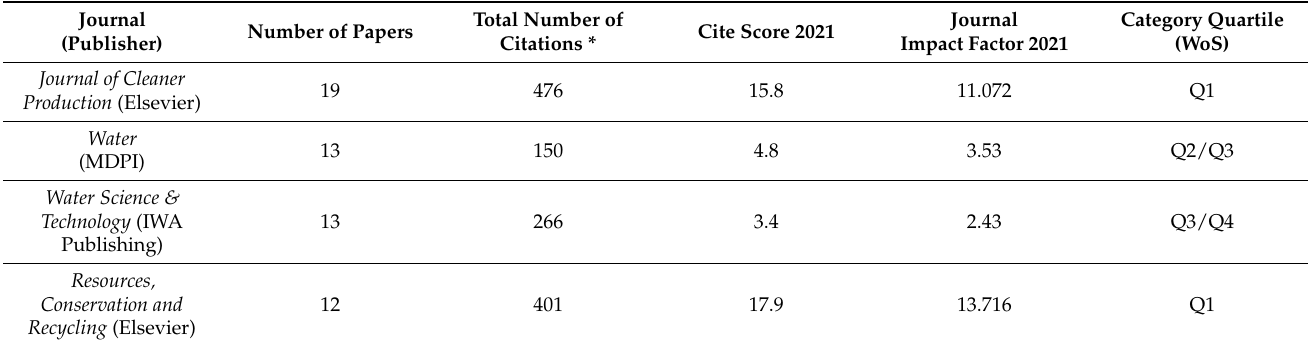
Table 11. The most productive journals in greywater recycling domain.